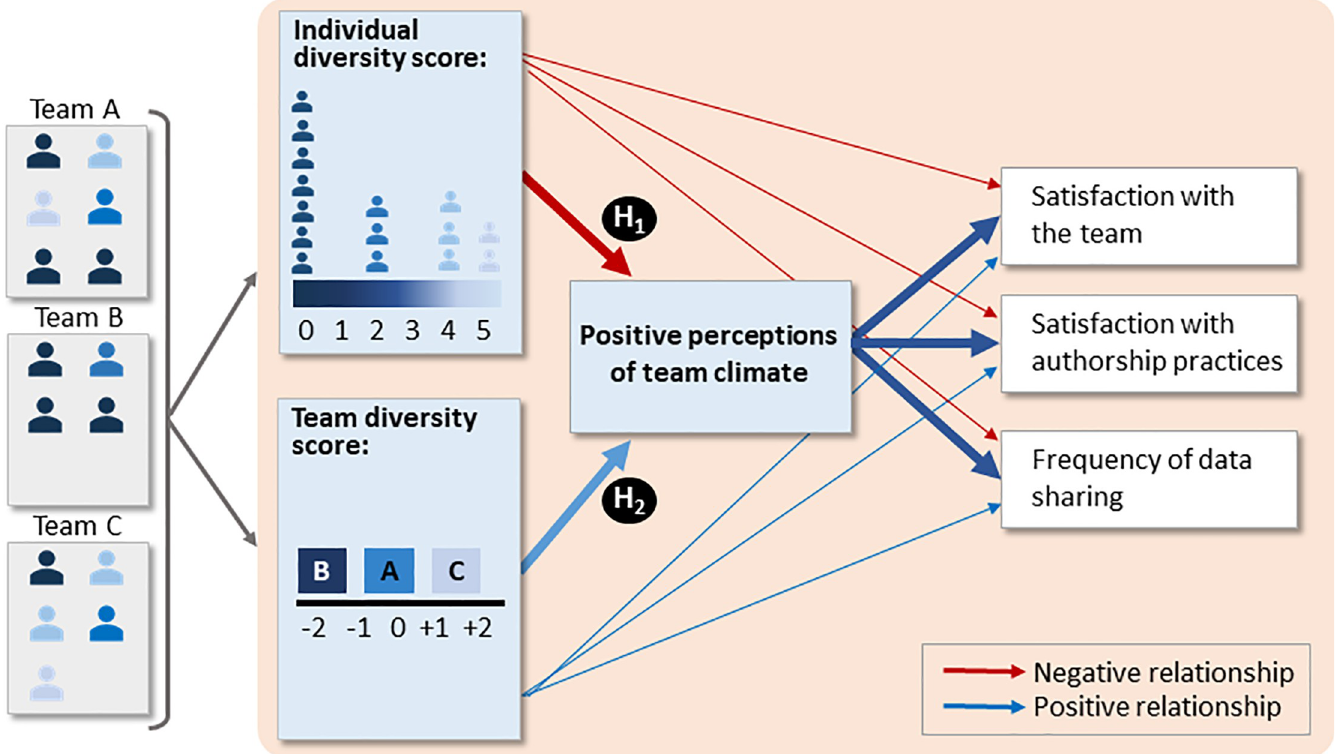
Fig 1. Conceptual model showing how individual and team diversity likely affects environmental science team outcomes, as mediated by climate perceptions. H 1 and H 2 are hypotheses about the relationships between demographic and scientific diversity, team climate, and team outcomes (see text for details). Line thickness indicates hypothesized strength of